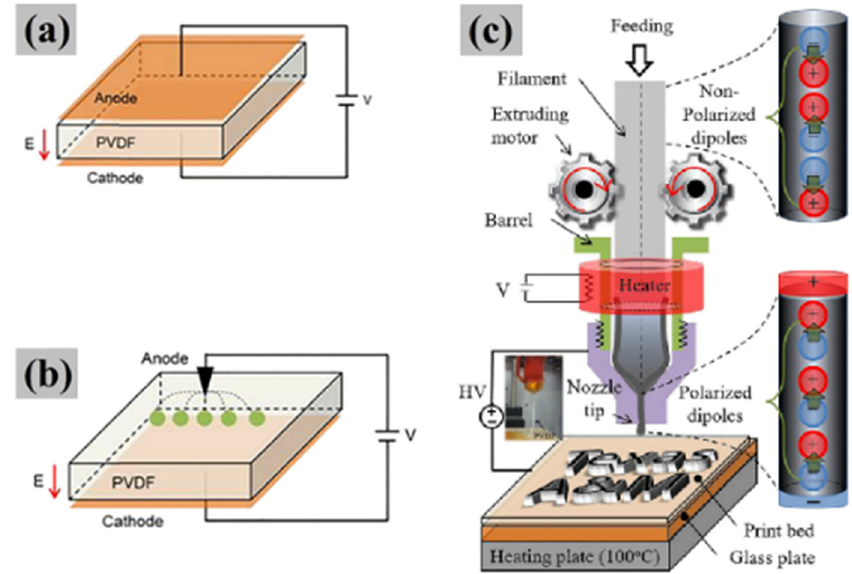
Figure 16: ( a ) Contact poling; ( b ) corona poling; and ( c ) a schematic of the EPAM process. Stretching and poling are fi nished in a single step [ 137 ] .